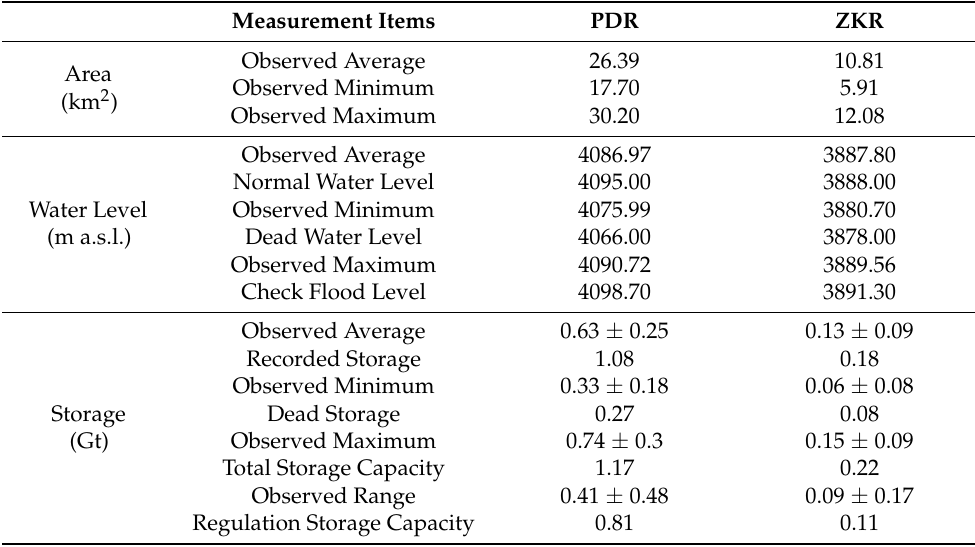
Table 1. Basic reservoir information and statistical data of the inundation area and water storage of ZKR and